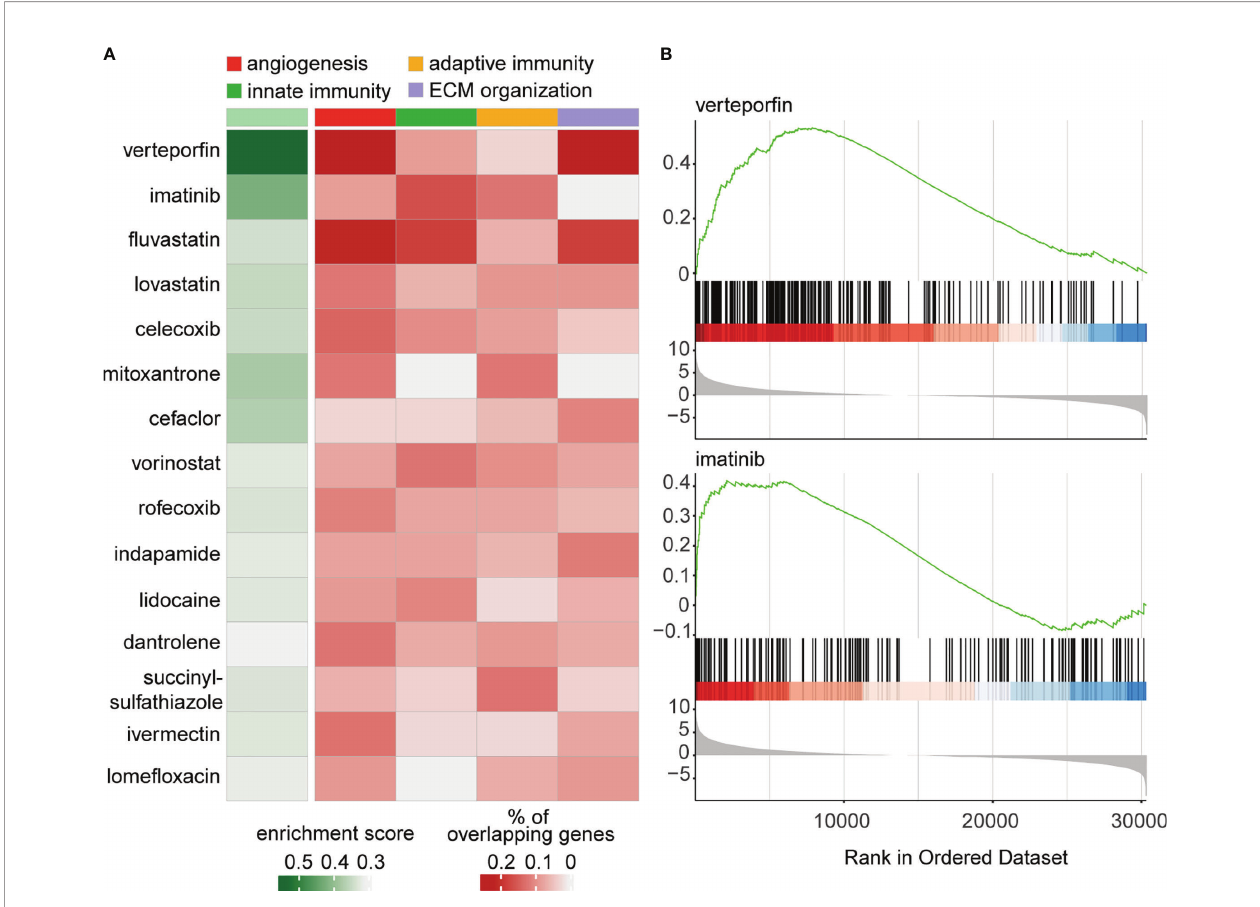
FIGURE 5 | Transcriptome-based drug repurposing for application in retinal neovascularization. (A) Heatmap of drugs for potential application in treatment of retinal neovascularization. The enrichment score was calculated for drugs, associated with the modulation of four disease-relevant processes: “ angiogenesis ” (red), “ innate immunity ” (green), “ adaptive immunity ” (ocher) and “ extracellular structure organization ” (lilac). The drugs are ordered according to the sum of enrichment score and mean of percentage of overlapping genes associated with the four biological processes. (B) Gene set enrichment analysis (GSEA) enrichment score curves for the most prominent drugs in above-mentioned analysis – vertepor fi n and imatinib. The green curves in the upper part of both graphs depict the enrichment score, which is the running sum of the weighted enrichment score for the respective drug. The lower parts show the ranked list of RNV genes ordered by llog2 fold change (RNV vs . ILM); every gene, which is downregulated by the indicated drug, is represented by a black bar in the middle of the